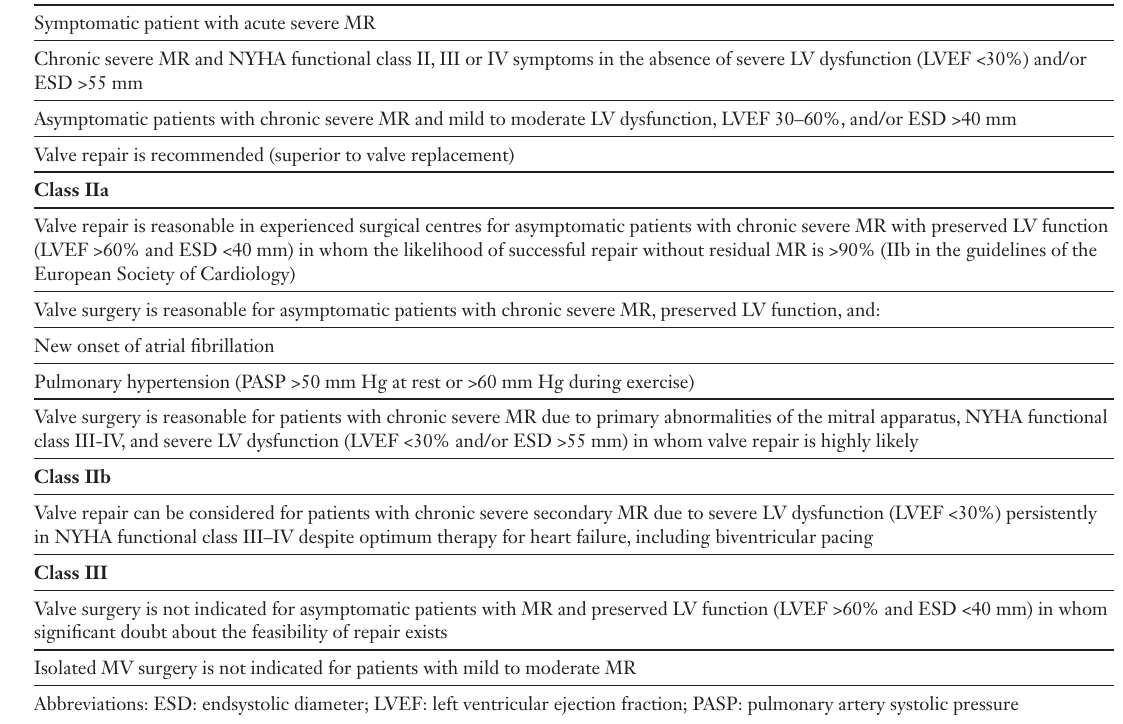
Figure 4 Left panel: Classical quadrangular resection for mitral valve prolapse. Right panel): New ring design aimed at improving annular